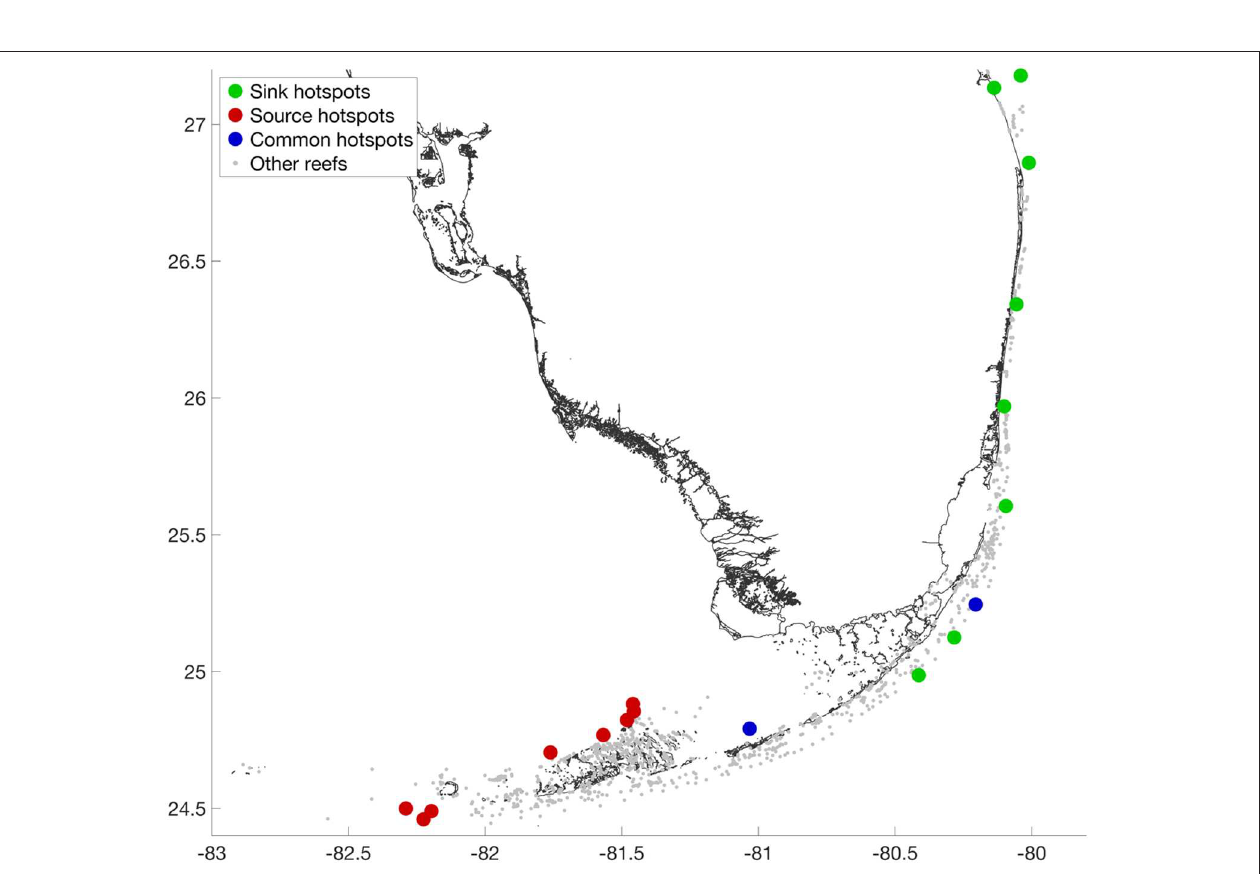
FIGURE 5 | Top 1% source and sink reefs obtained with the PageRank algorithm. The top sink reefs are all located downstream, on the outer shelf. These reefs have the most robust supply of larvae and should be among the most resilient reefs. The top source reefs are located upstream of the two main connectivity pathways. These are the reefs that are most useful to the rest of the